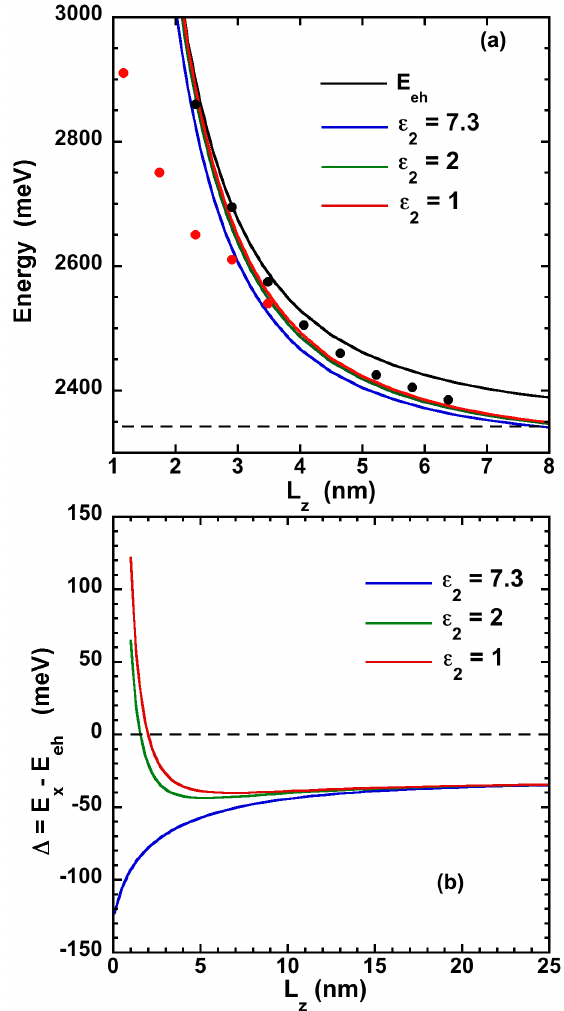
Figure 1. ( a ) Free e-h pair energy E eh (black line) and excitonic energy E X with different dielectric mismatches (the outside dielectric constant ε 2 varying from 7.3 to 1), for CsPbBr 3 . The dashed line correspond to the bulk gap energy E g . The black and red symbols are experimental data are from the works in [28,29], respectively. ( b ) Energy difference ∆ = E X − E eh for different dielectric